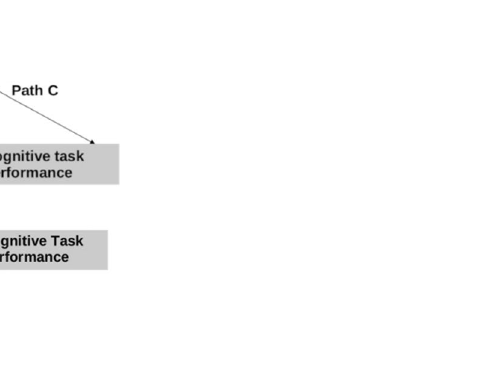
Table 3. Distribution of responses to questions in the Parent Demographic Survey (PDEM) related to religion. Percentages are out of n = 5566 participants.